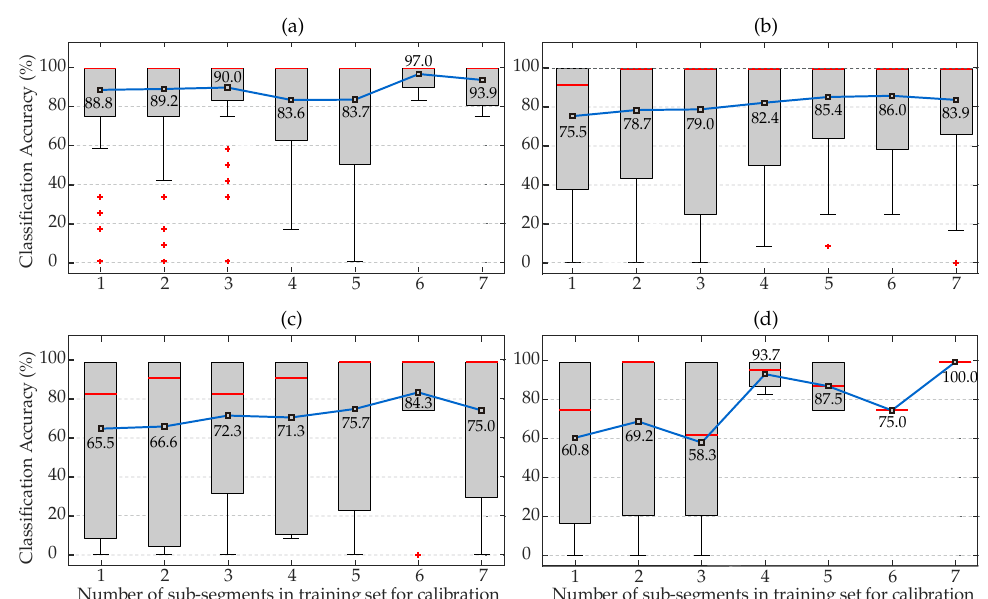
Figure 5. Classification accuracy to distinguish between NTS and HTS individuals using KNN sequential validation of segments with calibration distant from test measurements. ( a ) Distance below 1 h. ( b ) Distance between 1 and 6 h. ( c ) Distance between 6 and 24 h. ( d ) Distance above 24 h. In each box, the red line indicates the median, and the bottom and top edges indicate the 15th and 85th percentiles, respectively. The whiskers extend to the most extreme data points not considered outliers, and the red symbol (+) stands for outliers. Black squares inside each box indicate mean